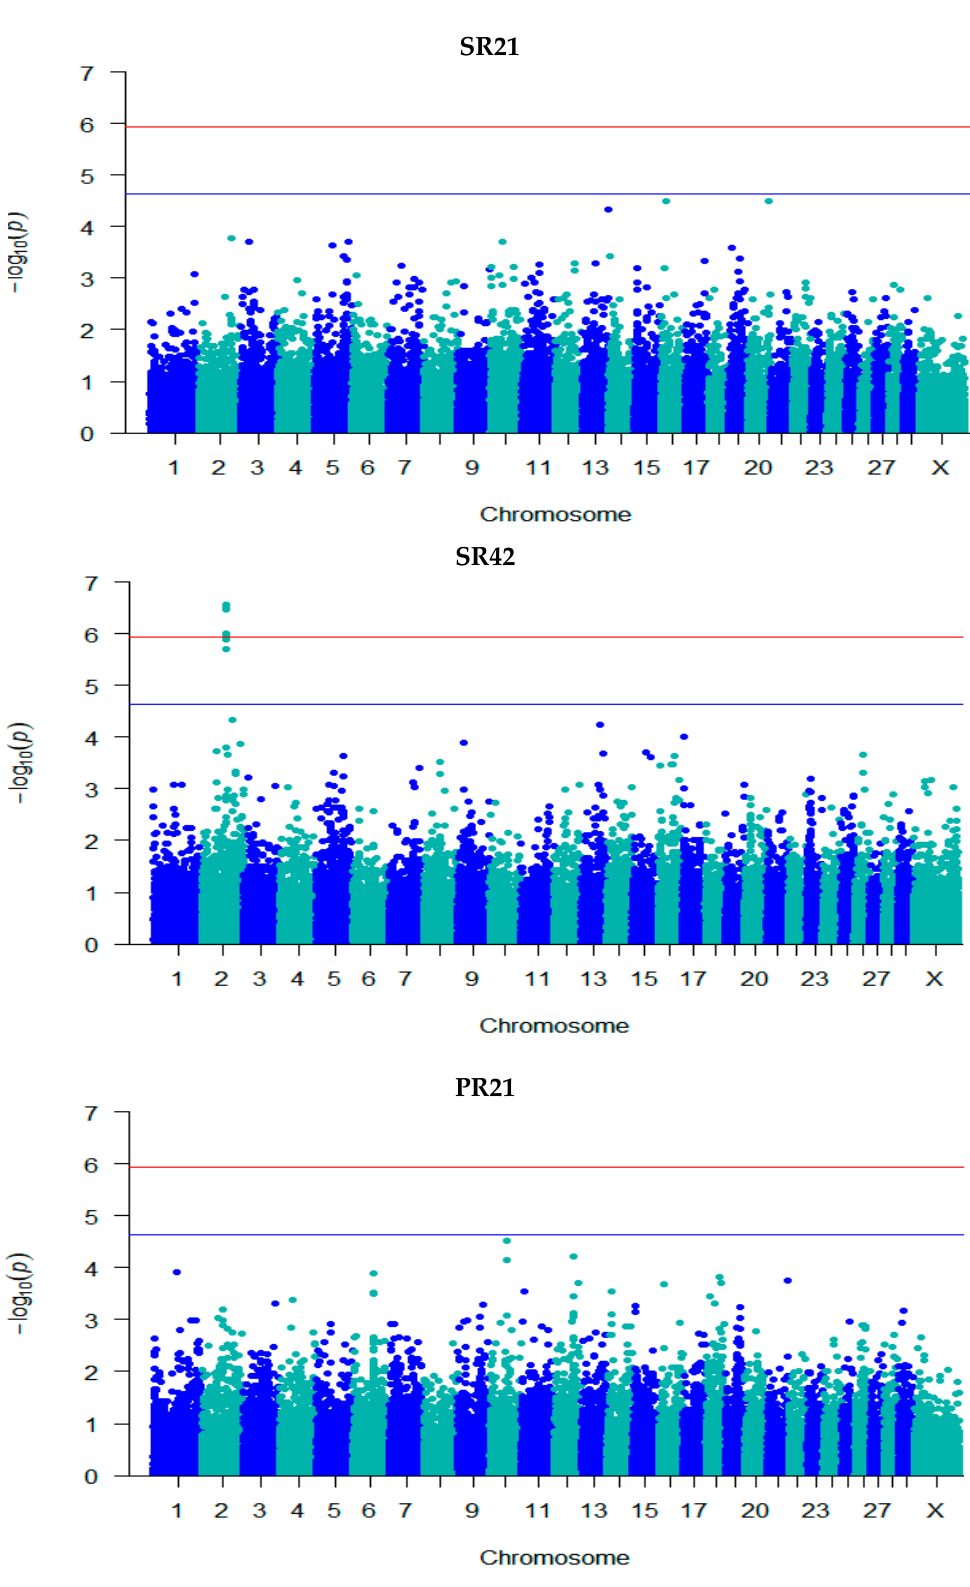
PR42 Figure 2. Cont